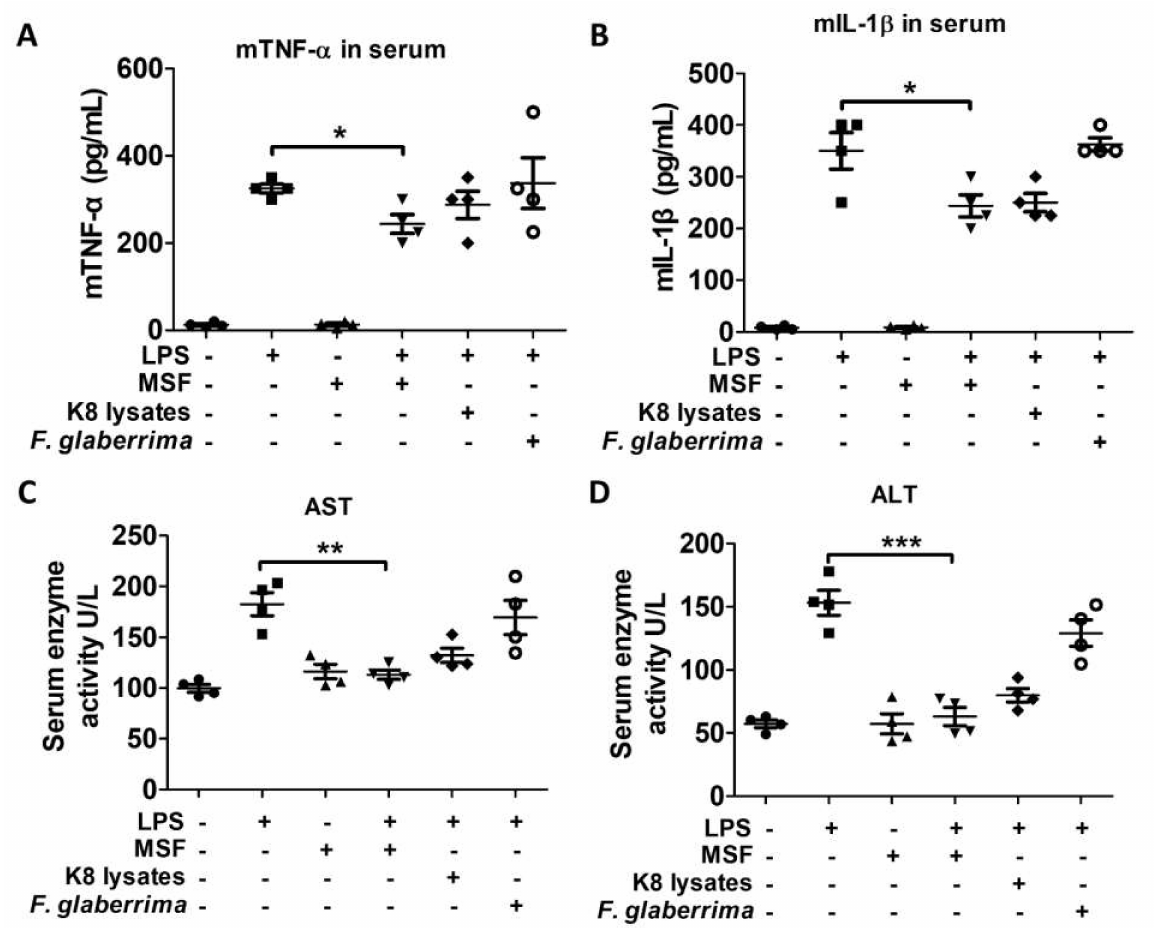
Figure 7. MSF reduced LPS-induced systemic inflammation. BALB/c mice (7 weeks old, 4 mice/group) serum was collected 8 h after i.p. injection of 20 mg/kg LPS following pre-injection of PBS, 400 µ g/mouse MSF, 400 µ g/mouse K8 lysates, or 5 µ g/mouse of F. glaberrima for 24 h. TNF- α ( A ) and IL-1 β ( B ) levels in the serum were measured by ELISA. Serum AST ( C ) and ALT ( D ) levels were observed. Statistical analyses were conducted with an unpaired two-tailed t -test. * p < 0.05; ** p < 0.01; *** p <